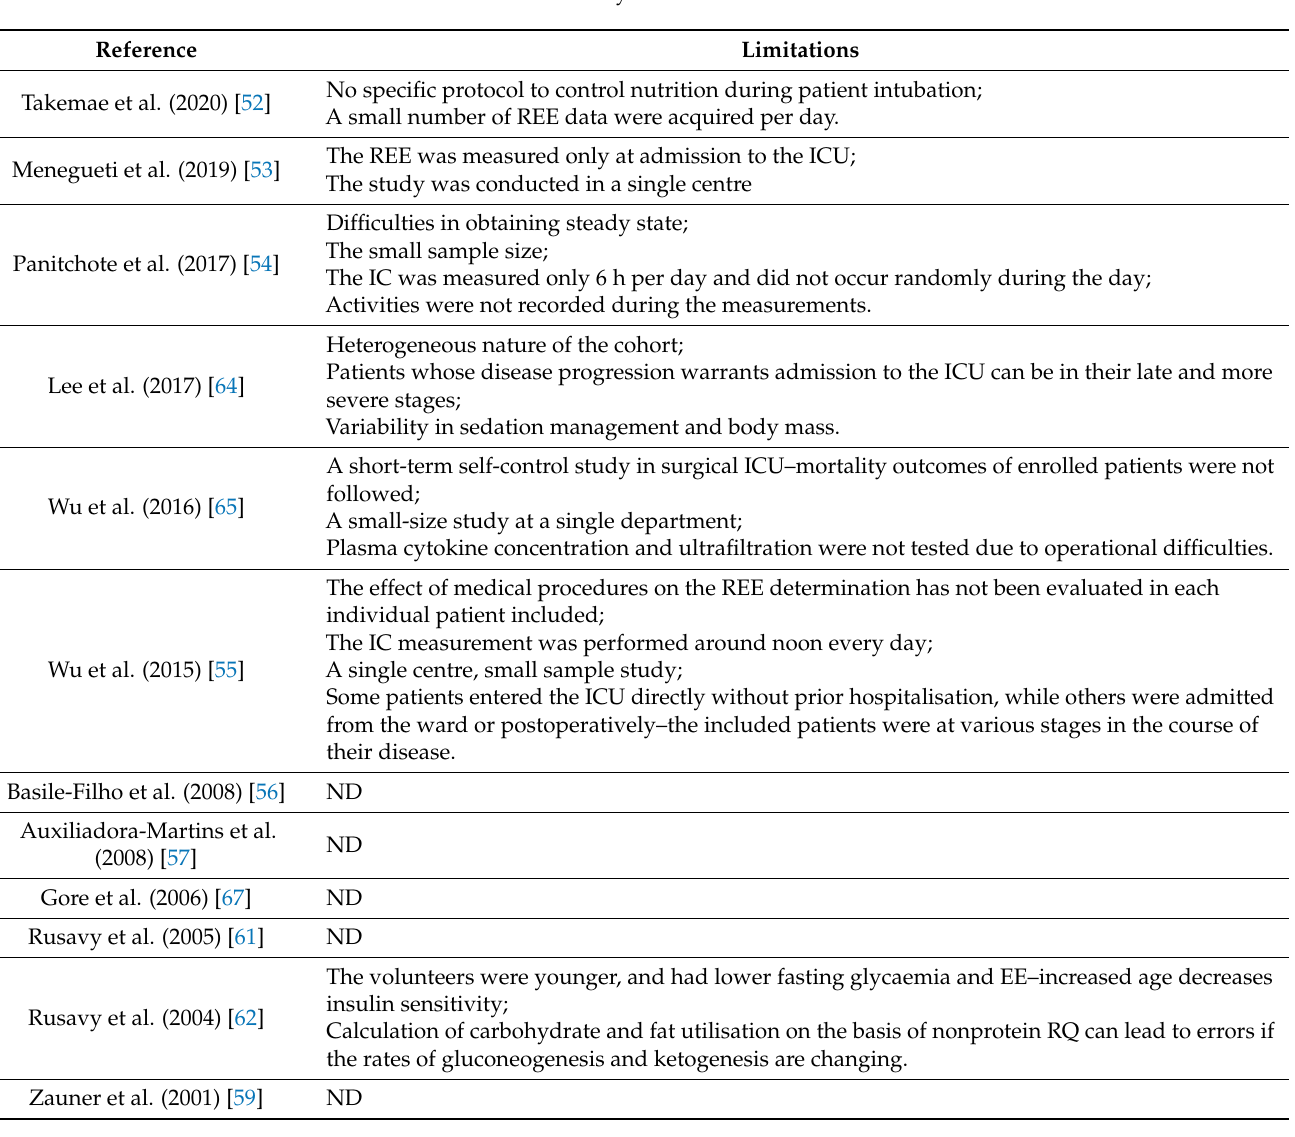
Table 4. Limitations of the analysed